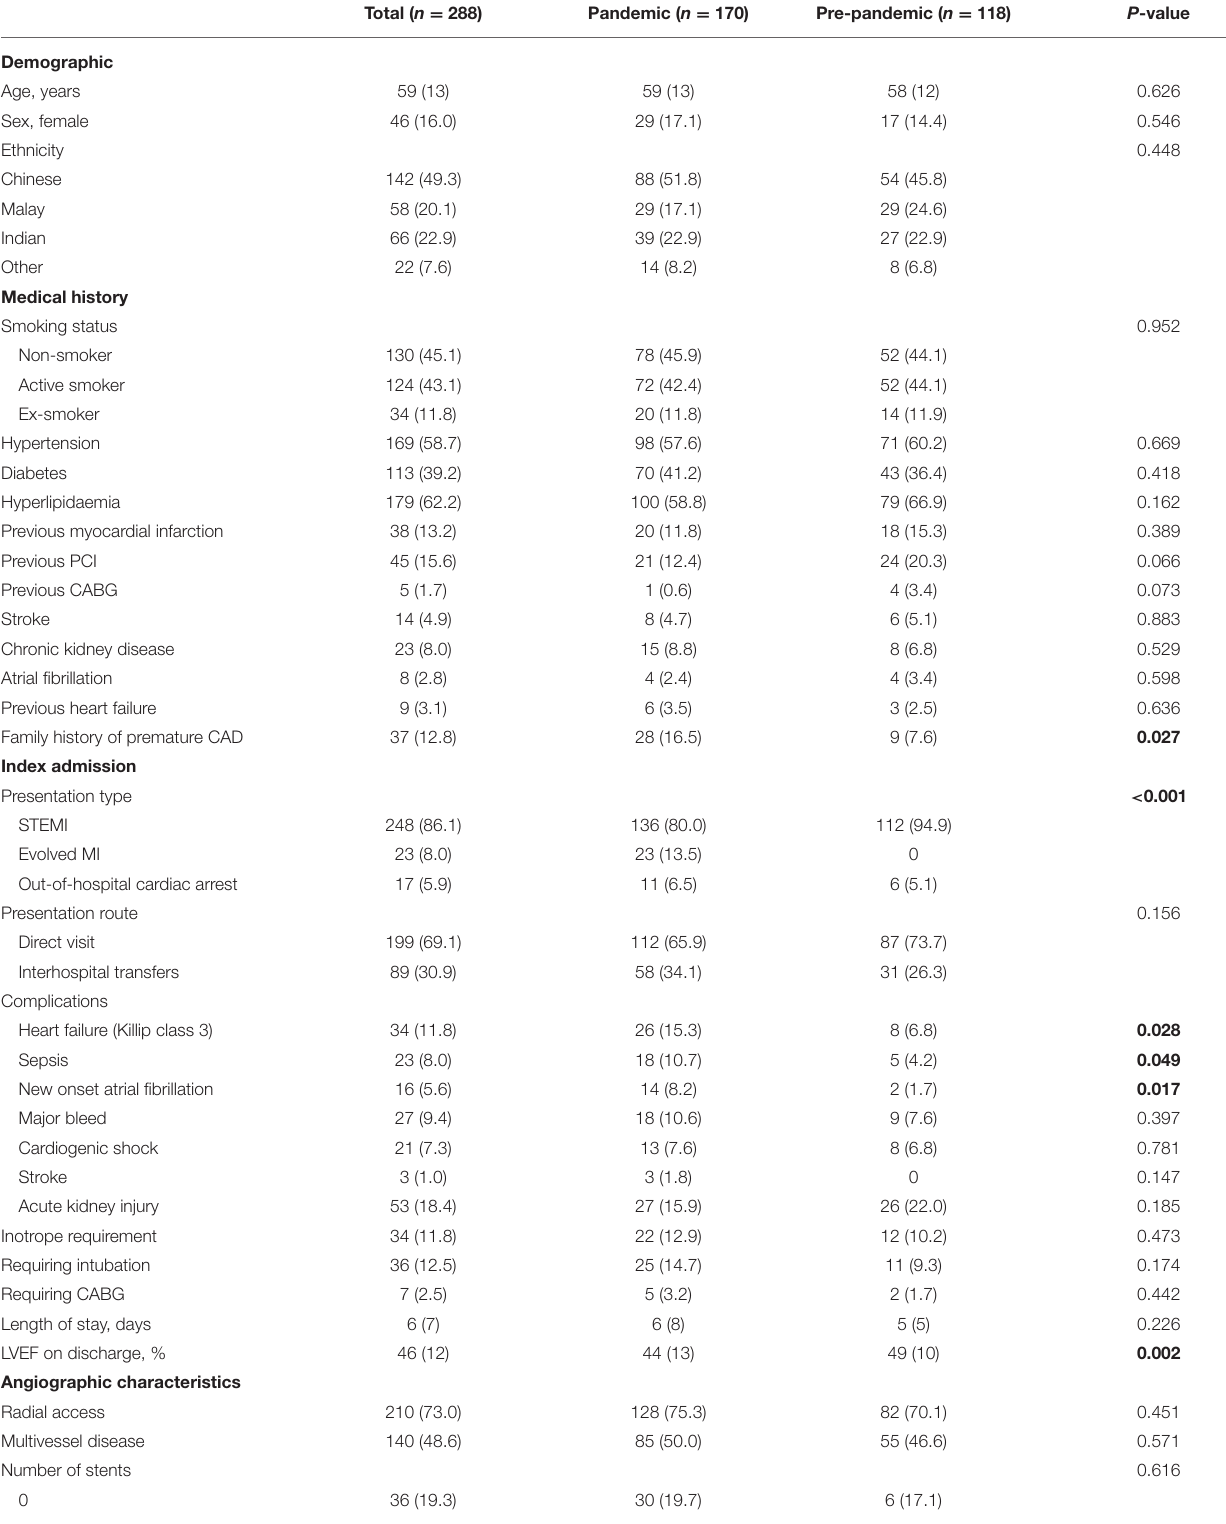
TABLE 1 | Baseline characteristics of study participants with ST-segment elevation myocardial infarction during index admission according to pre-pandemic or pandemic